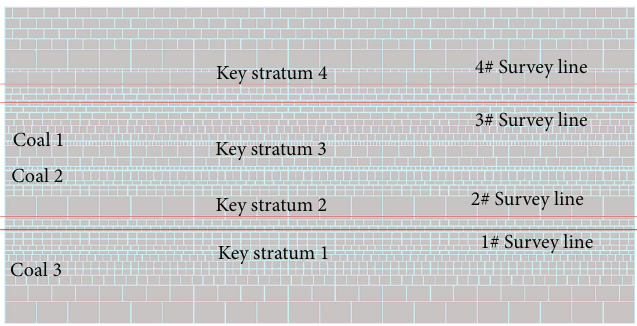
Figure 6: Repeated mining model and survey line